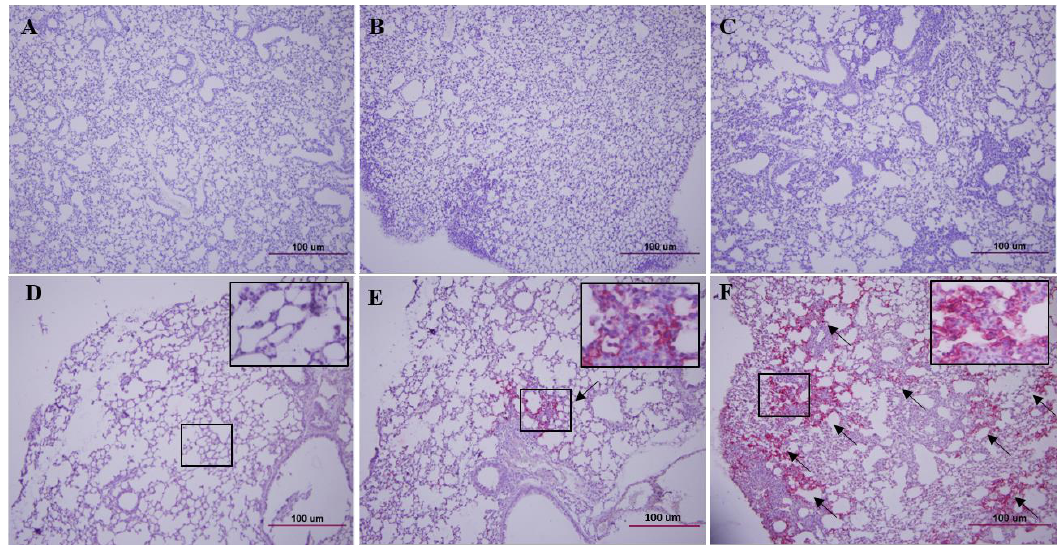
Figure 2. Lung histopathology and antigen staining of cold-adapted SARS-CoV-2 vaccine strain in hACE2 transgenic mice . Lung tissues (Figure 1C) of K18-ACE2 mice on 6 days p.i. were stained with hematoxylin and eosin ( A,B,C ) (×100), and SARS-CoV-2 NP antibody ( D,E,F ) (×100). A and D , lung tissues of PBS-mock mice, B and E , lung tissues of mice i.n. infected with cold adapted SARS-CoV-2 (CoV-2-CNUHV03-CA22 o C) (2 × 10 4 pfu), C and F , lung tissues of mice infected with wild-type SARS-CoV-2 (CoV-2-CNUHV03) (2 × 10 4 pfu). Arrow: positive antigen staining. Inlet(X400)